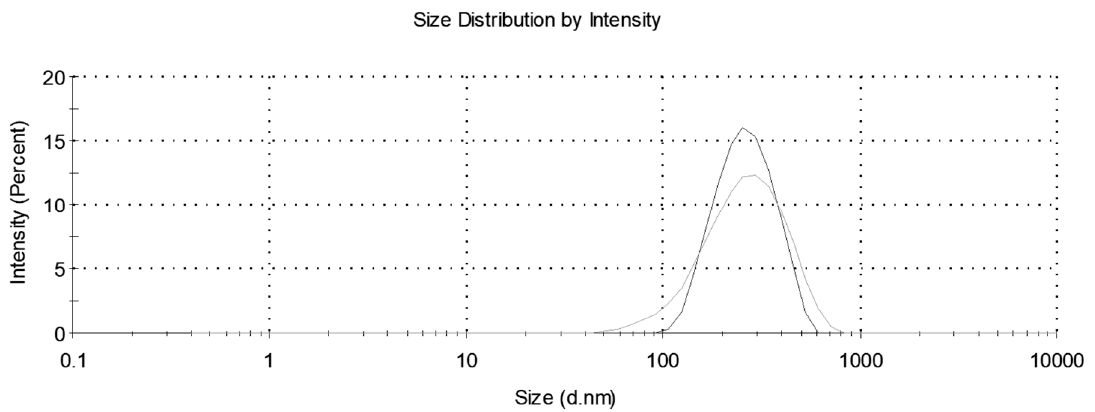
Figure 9. Particle size distribution of nanoplastic particles (Nano ZS Zetasizer) following ballasted flocculation. Lines indicate replicate results.